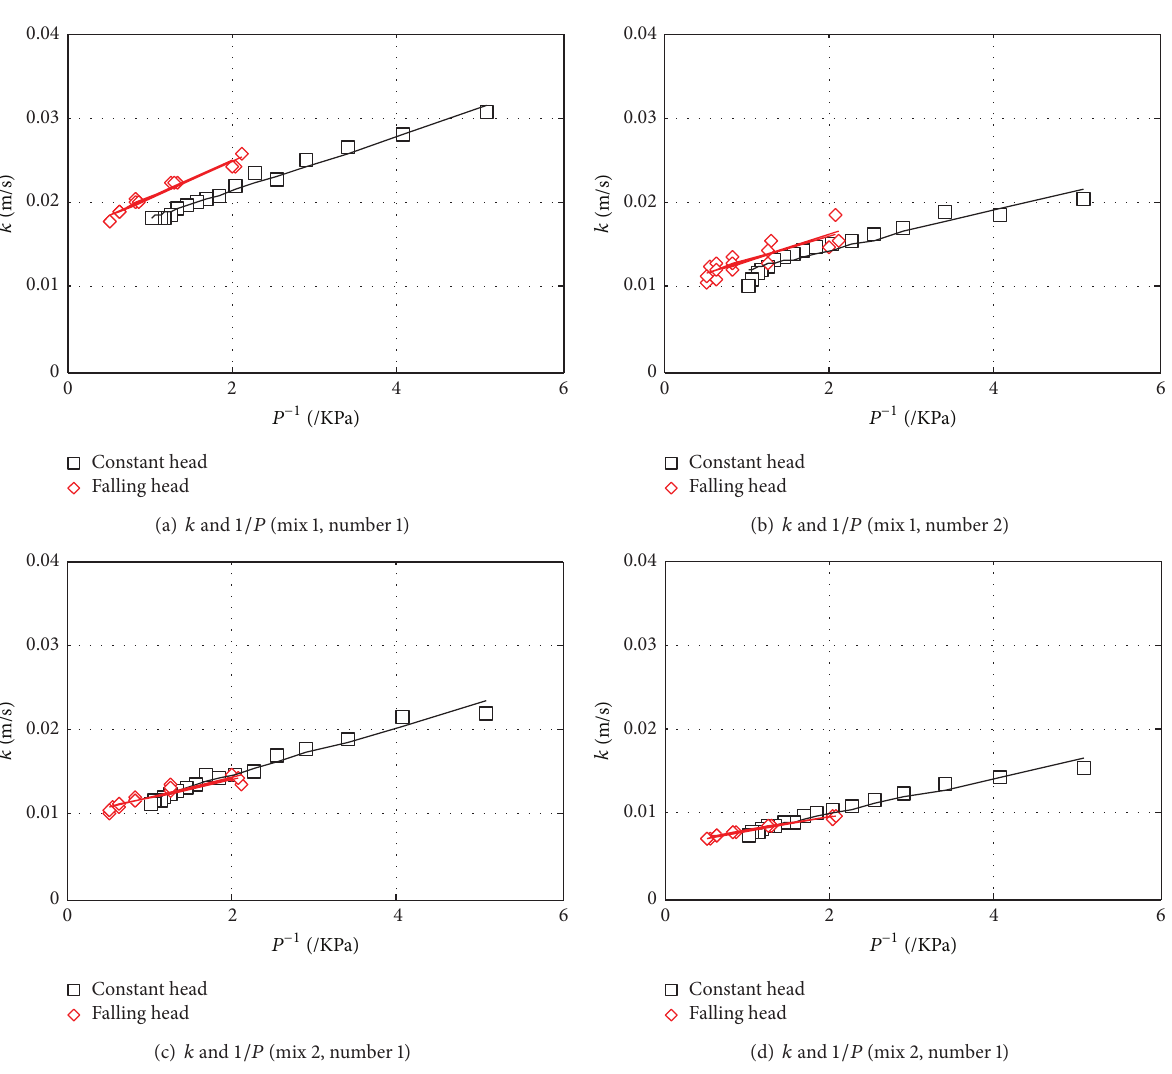
Figure 4: Klinkenberg Effect of the measured permeability of pervious